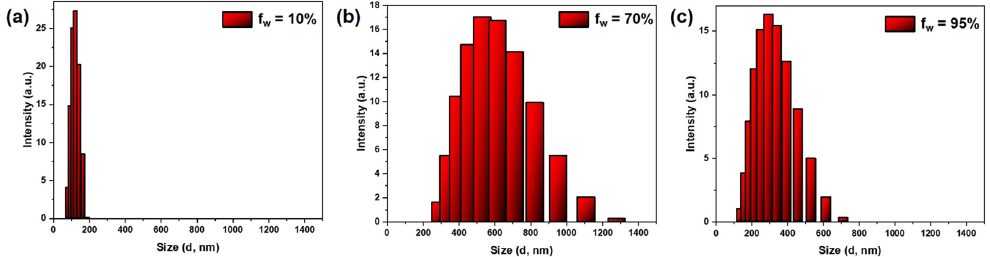
Figure 2. DLS measurements of L1 -aggregates formed in ( a ) 10, ( b ) 70, and ( c ) 95% MeOH–water solvent system.